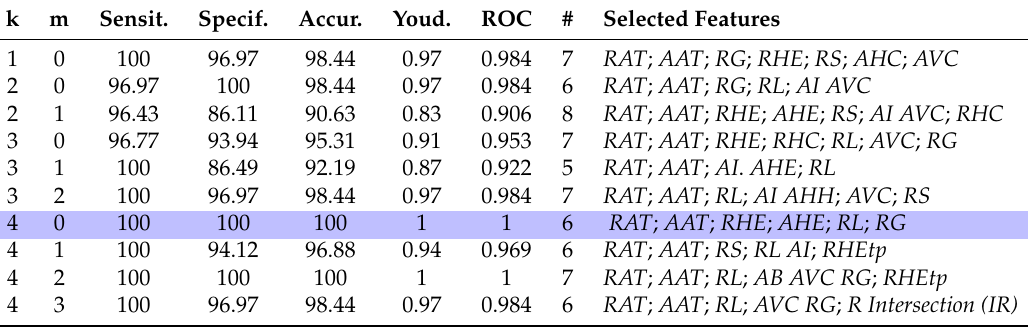
Table 4. Result of the classification with C-Support Vector Classification (SVC) for each series after the feature selection. Sensit.